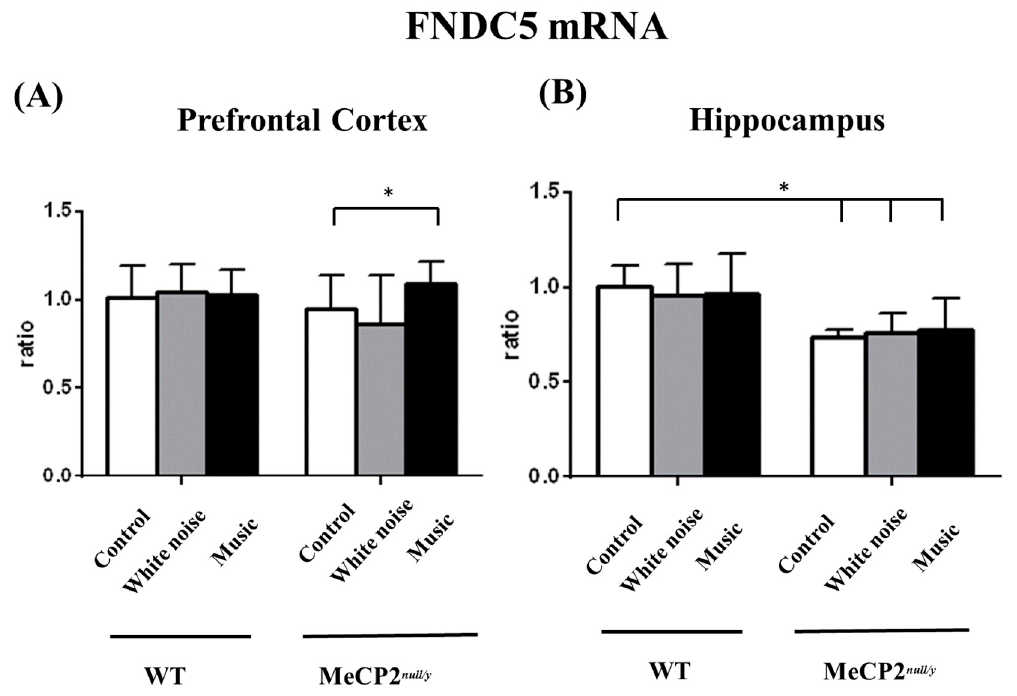
Figure 6. Comparison of FNDC5 expression in the PFC and hippocampus between wild-type and mecp2 null/y mice. ( A ) Mecp2 null/y mice that underwent a music-based intervention showed significantly increased FNDC5 expression in the PFC as compared with control mecp2 null/y mice. ( B ) Mecp2 null/y mice had significantly lower FNDC5 expression as compared with all wild-type mice (* p < 0.05).